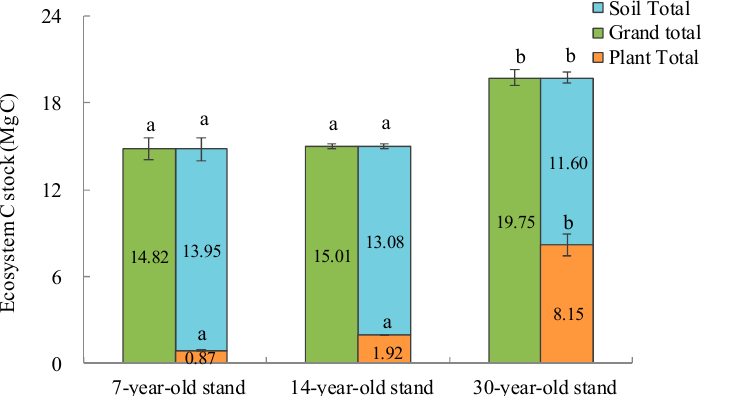
Figure 1. Variability of carbon stocks across a chronosequence of Masson pine plantations. Significance level: *, p < 0.05.